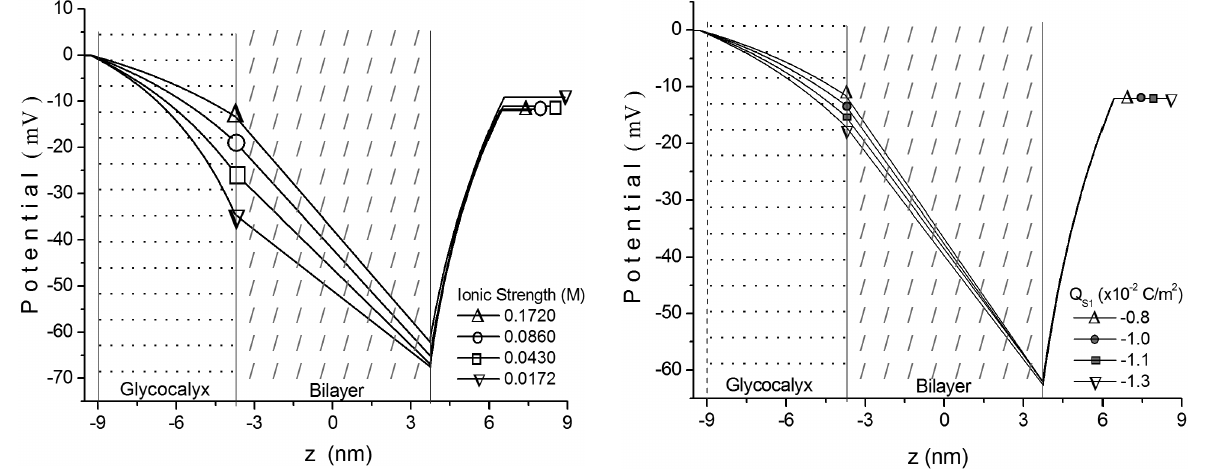
Figure 3 - Electric potential pro fi le for four values of surface Q ): -0.8x10 -2 C, -1.0x10 -2 C, -1.1x10 -2 C, charge density ( 1 S -1.3x10 -2 C, considering the situation A. Potential and charge density at S were estimated based on the model of Hsu et al. g (1996), Eqs. 18 and 19, using membrane values shown in Table I, and electrophoretic data given in Table